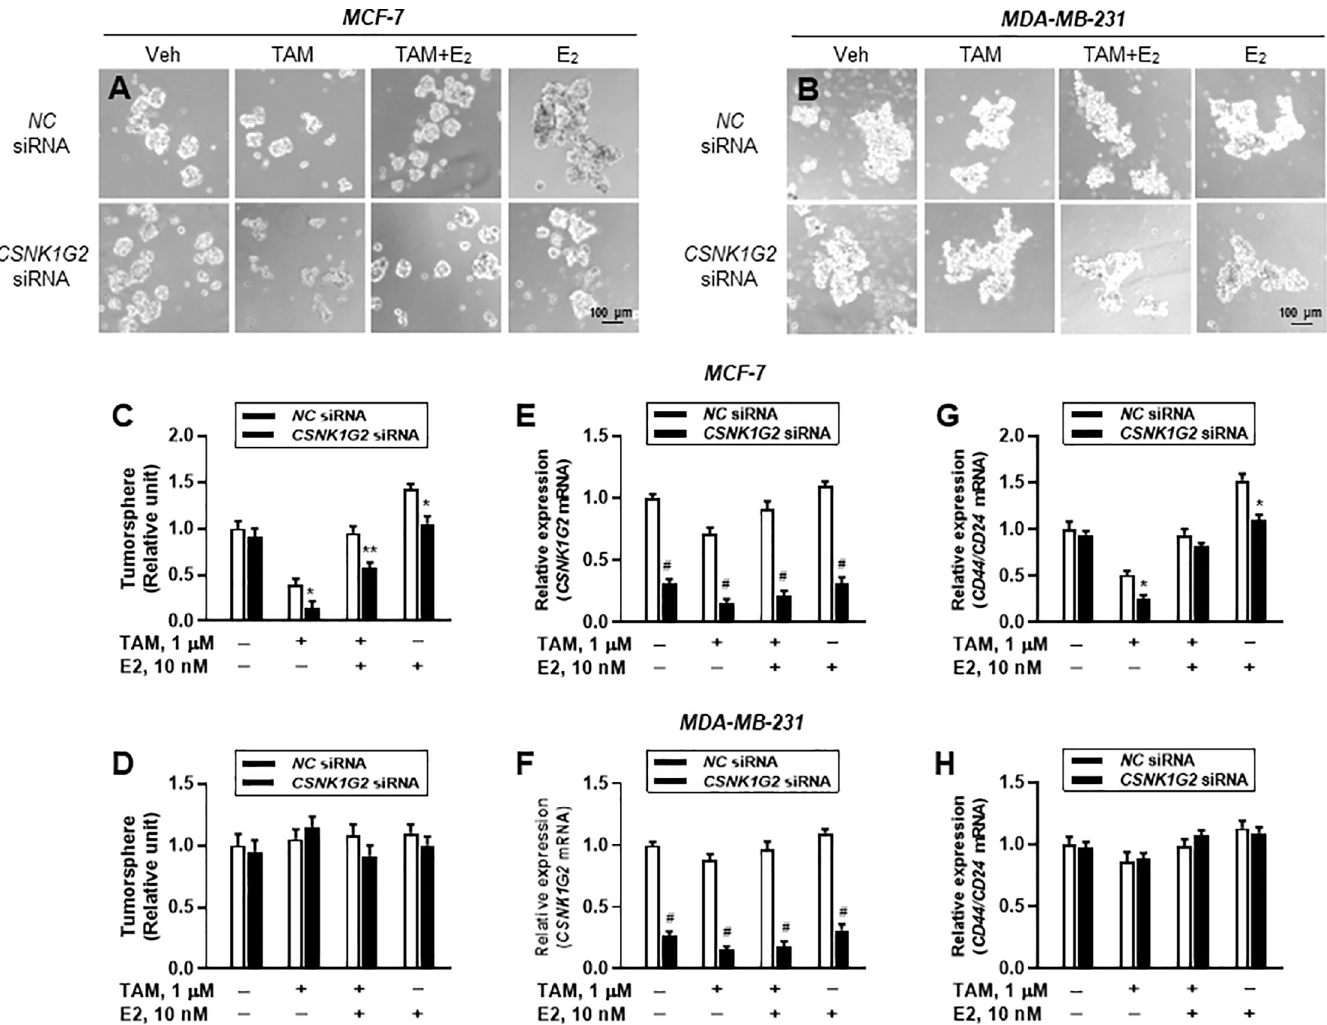
Fig 3. Suppressed tumor sphere formation and expression of cancer stem cells by CSNK1G2 knockdown in ER + breast cancer cells. Representative images of tumor spheres in NC or CSNK1G2 siRNA-transfected (A) MCF-7 and (B) MDA-MB-231 after treatment with vehicle, 1 μ M TAM alone, 1 μ M TAM plus 10 nM E 2 , or 10 nM E 2 alone. Both cells were plated in ultralow-attachment 6-well plates at a density of 2,000 cells/well and cultured in tumor sphere medium with or without each drug for 7 days 24 h after transfection. Quantitative analysis of tumor sphere numbers in (C) MCF-7 and ( D) MDA-MB-231 cells. Tumor size and numbers were analyzed by ImageJ software. (E, F) CSNK1G2 knockdown efficiency and (G, H) the ratio of CD44 / CD24 mRNA in MCF-7 and MDA-MB-231 was quantified by RT-qPCR. Data are presented as means (SD) (n = 4); � P < 0.05, �� P < 0.01, # P < 0.001 vs . each represented